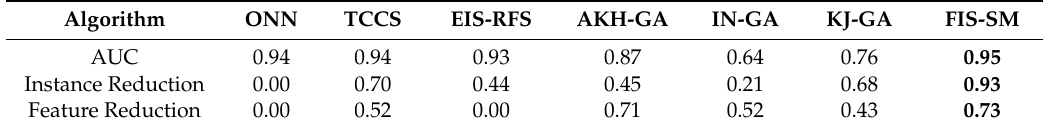
Table 9. Performance of the algorithms to predict high capabilities in kindergarten children.